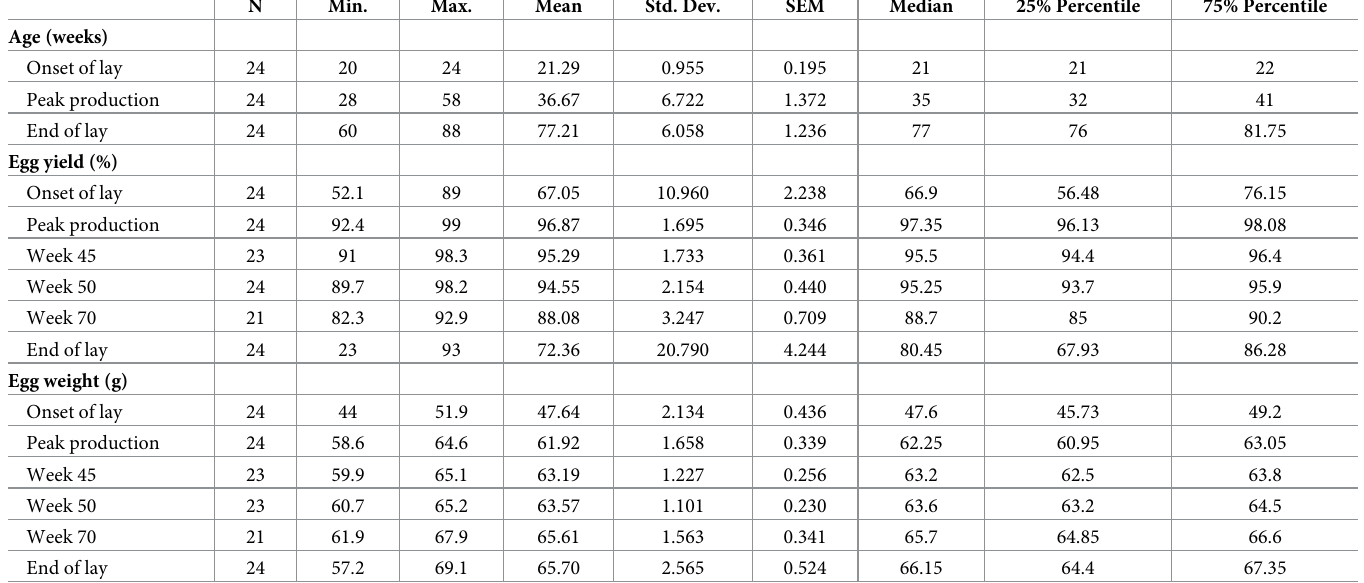
Table 4. Overview on production data from 24 flocks.